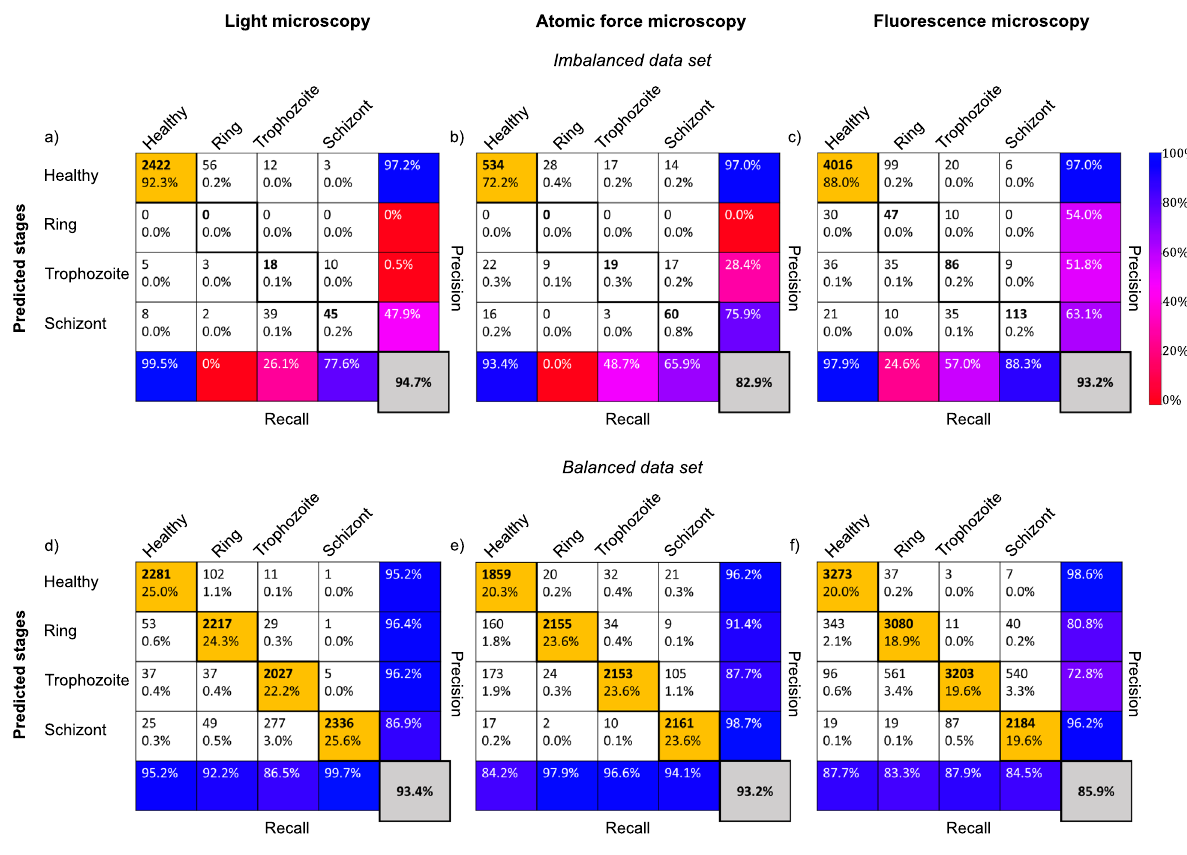
Figure 4. Classification performance of the convolutional NN on 2D microscopy images. The performance parameters, as obtained on imbalanced (non-augmented) sets of light microscopy, AFM and fluorescence microscopy images, are respectively summarised in the confusion matrices of panels ( a ), ( b ), and ( c ). The confusion matrices obtained for the corresponding balanced (augmented) data sets are shown in panels ( d ), ( e ), and ( f ). The cells in the single-RBC cutouts were classified into four categories: healthy, ring, trophozoite, and schizont. The confusion matrices show the performance of the classification for each microscopy technique on the test set. The labels of the rows are the categories predicted by the NN-based classifier, while the labels of the columns indicate the classification by human experts. Correspondingly, the sum over a given column/row gives the number of cases falling into that category by human/NN classification. The diagonal elements correspond to the number of RBCs correctly classified by the NN, while the off-diagonal elements show false classifications. In each field, the number of counts as well as the corresponding percentage with respect to the total set are shown. In the last column, the precision for each of the four categories is shown. In addition, the recall values are displayed in the bottom column. Most importantly, the overall classification accuracy is displayed in the grey field in the bottom right corner. For the definition of the precision, recall, and overall accuracy values see the main text. For visual guidance, the diagonal fields with percentages > 18% have an orange background, while fields with the precision values (last column) have background colors according to the common colourbar on the